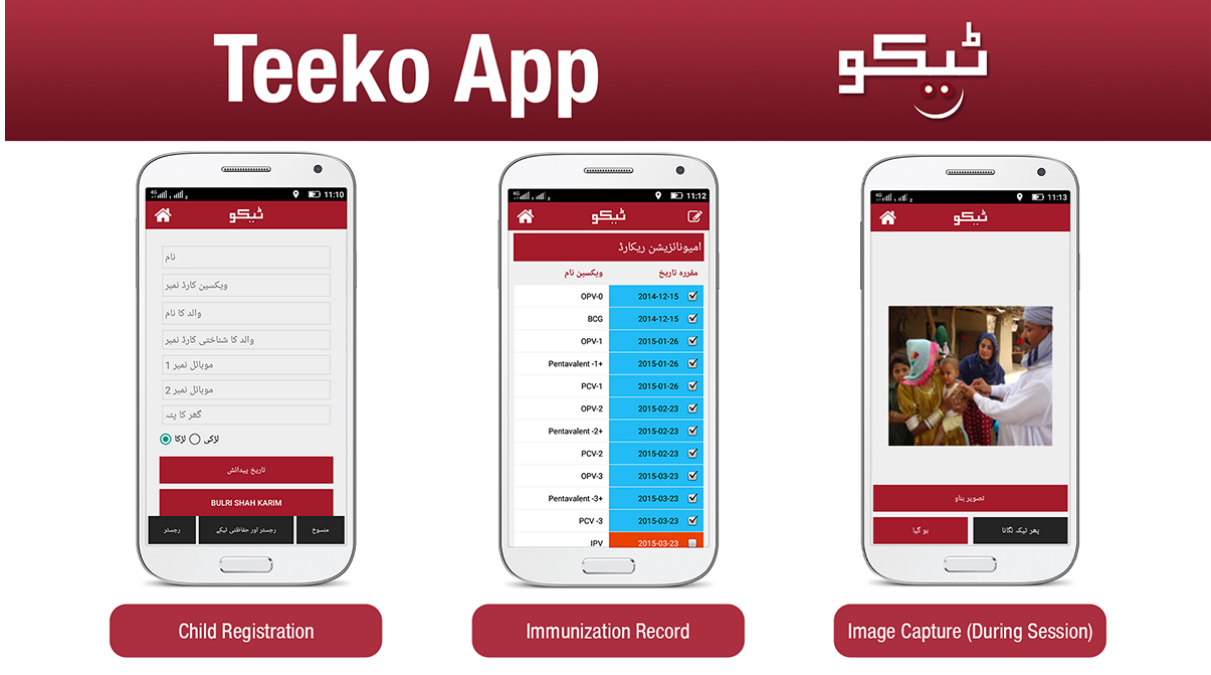
Figure 3. Examples of registration, an immunization record, and the image capture view on the Teeko